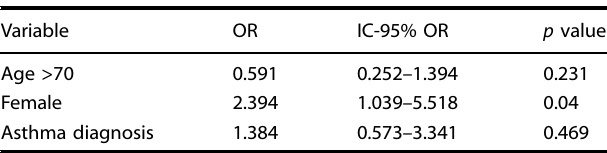
Table 6. Logistic regression